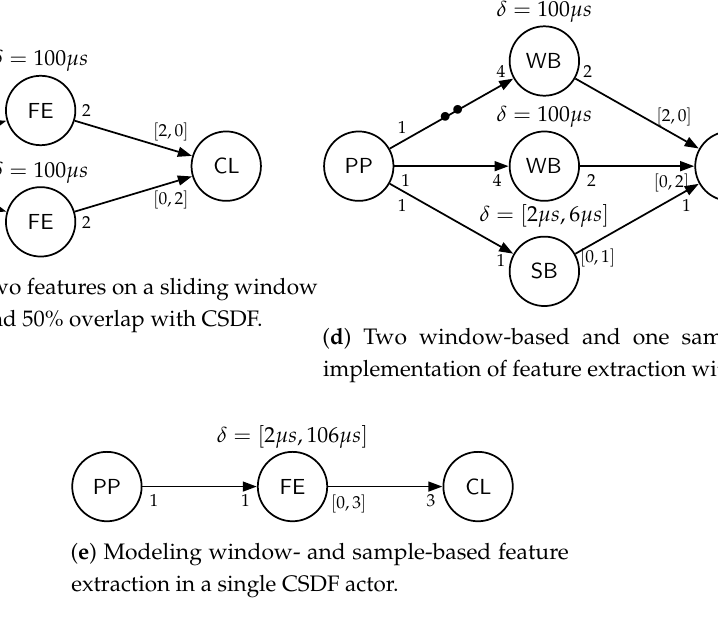
Figure 4. Modeling sliding window-based feature extraction with different levels of